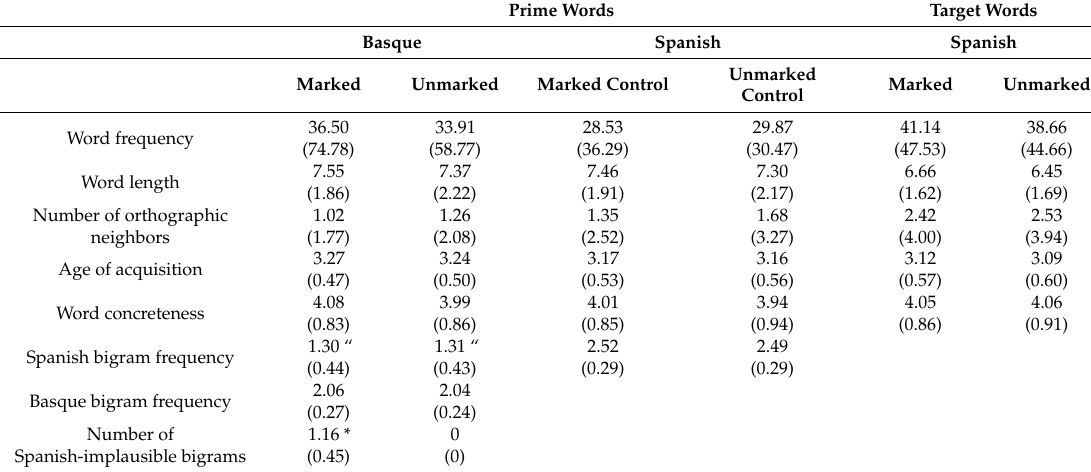
Table 2. Experiment 1: Mean values for each sub-lexical, lexical, and semantic factor in L1 (Spanish) and L2 (Basque) split by condition. Standard deviations are provided within